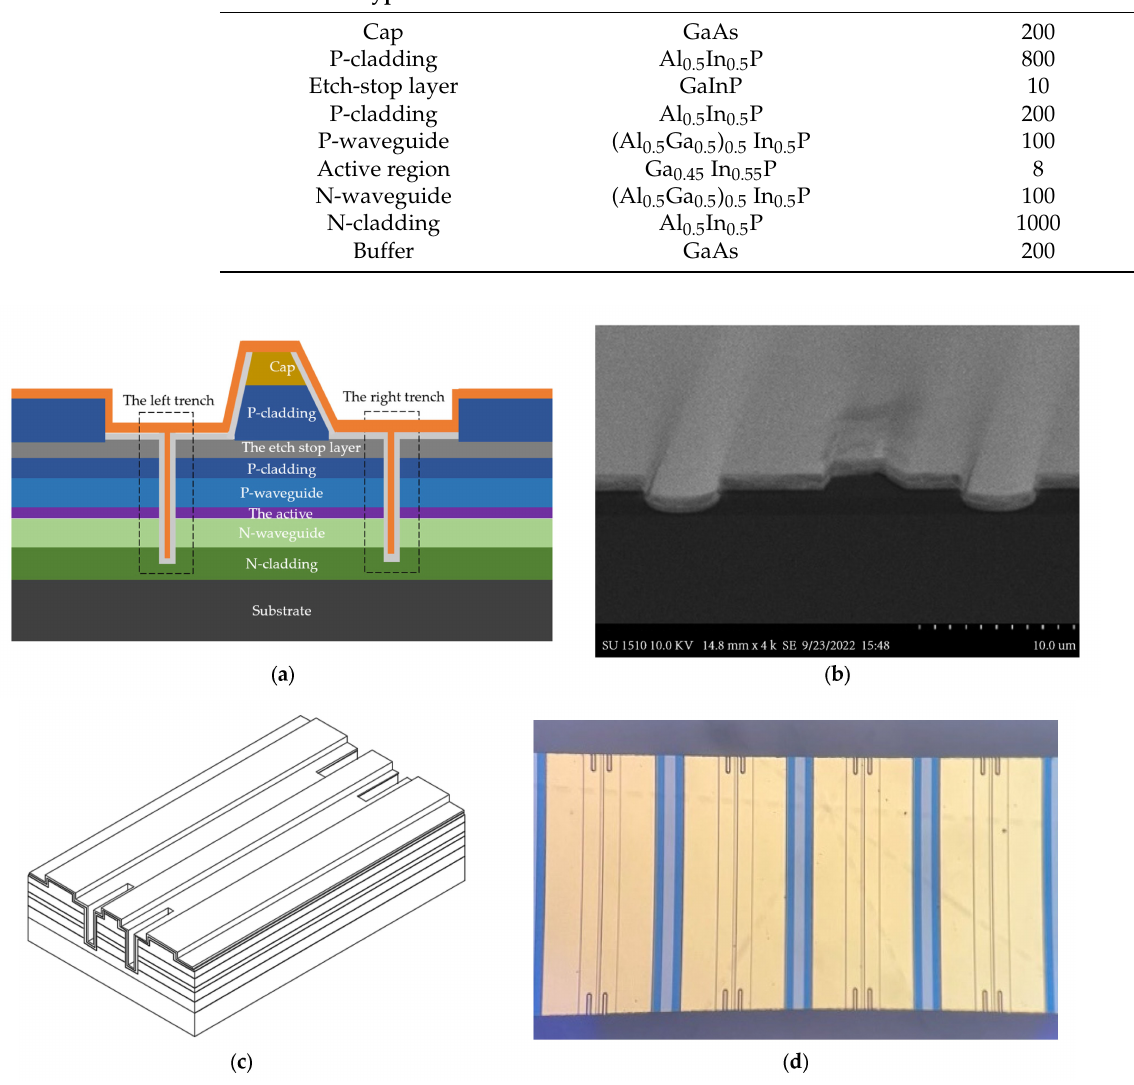
Figure 1. ( a ) Diagram of the layered structure of the diode laser; ( b ) SEM of the ridge waveguide; ( c ) diagram of the mode-modulation laser structure; ( d ) the appearance of the